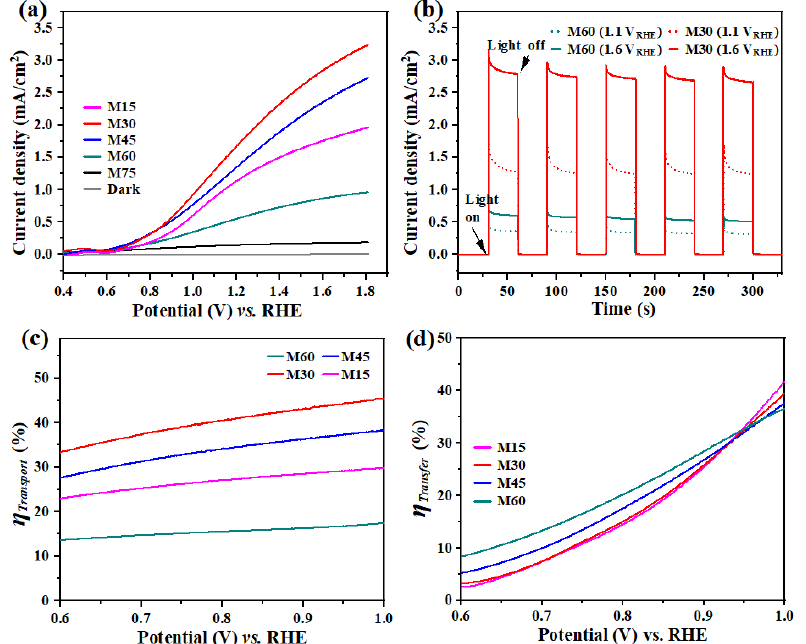
Figure 5. ( a ) Linear sweep voltammogram (LSVs) for the M15-M75 measured in 0.1 M Na 2 SO 4 under AM 1.5 irradiation and in the dark; ( b ) Variation of the current densities of the M30 and M60 under AM 1.5 irradiation at 1.1 V RHE and 1.6 V RHE ; ( c ) The calculated η transport and ( d ) η transfer of the M15-M60.